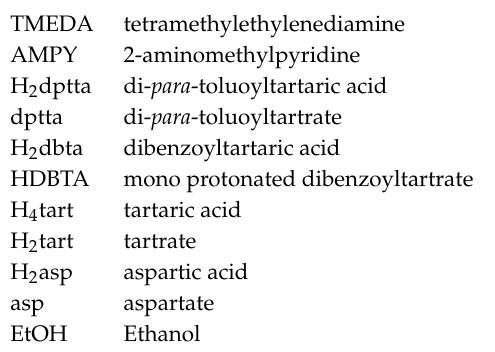
Table S1: Crystal data and refinement, Table S2: Bond length and U iso (H) for carbon bonded Hydrogen, Tables S3–S7: Selected geometric parameters (Å, ◦ ) for 1 – 3a , Tables S8–S12: Hydrogen-bond geometry (Å, ◦ ) in 1 – 3a